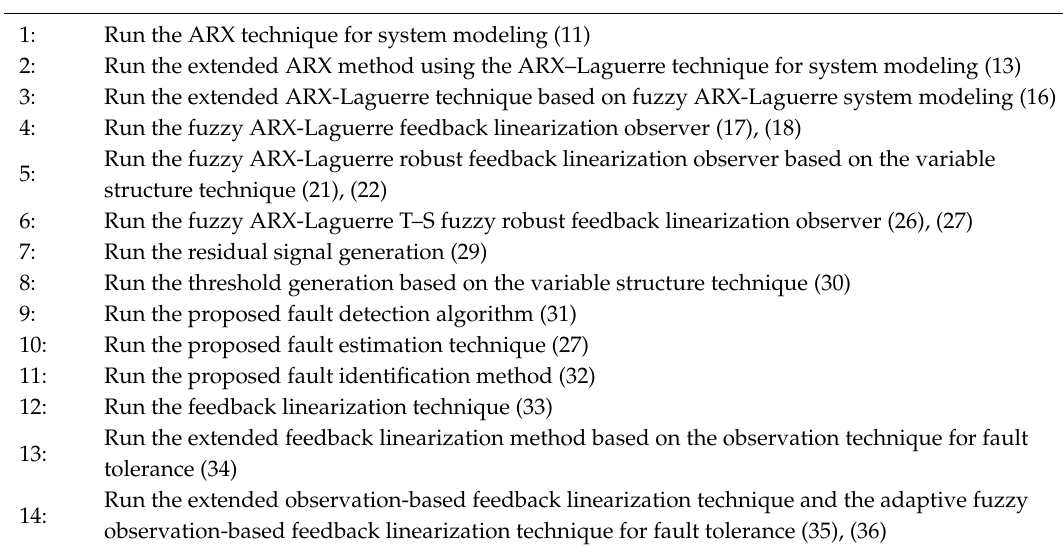
Figure 13. Fault-tolerant control for fuzzy feedback linearization method, observation-based feedback linearization method, and proposed method for a surgical robot for the sinus. Algorithm 1 Online tuning of the observation-based fuzzy ARX-Laguerre T–S fuzzy robust feedback linearization observer for fault detection, estimation, identification, and tolerant control of a surgical robot for the sinus.